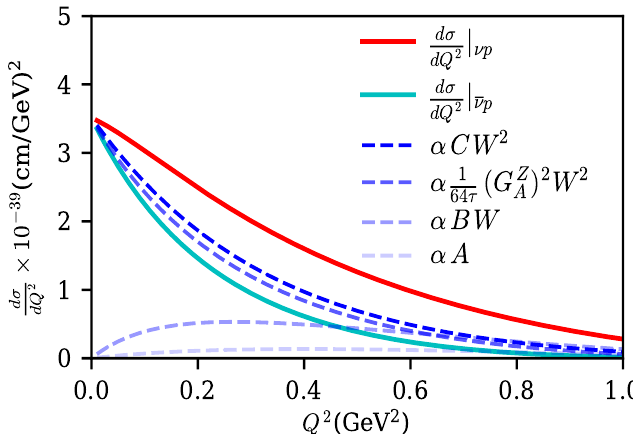
Figure 3 . Contributions from A ( Q 2 ), B ( Q 2 ), C ( Q 2 ) de(cid:12)ned in eq. (2.6) and G Z di(cid:11)erential cross sections for neutrino beam energy E (cid:23) = 1 GeV are shown as the dashed lines. The 2 Q 2 symbol (cid:11) = G is used in the (cid:12)gure for shorthand notation. The total di(cid:11)erential cross sections F 2 (cid:25) E 2 (cid:23) are shown with solid lines.